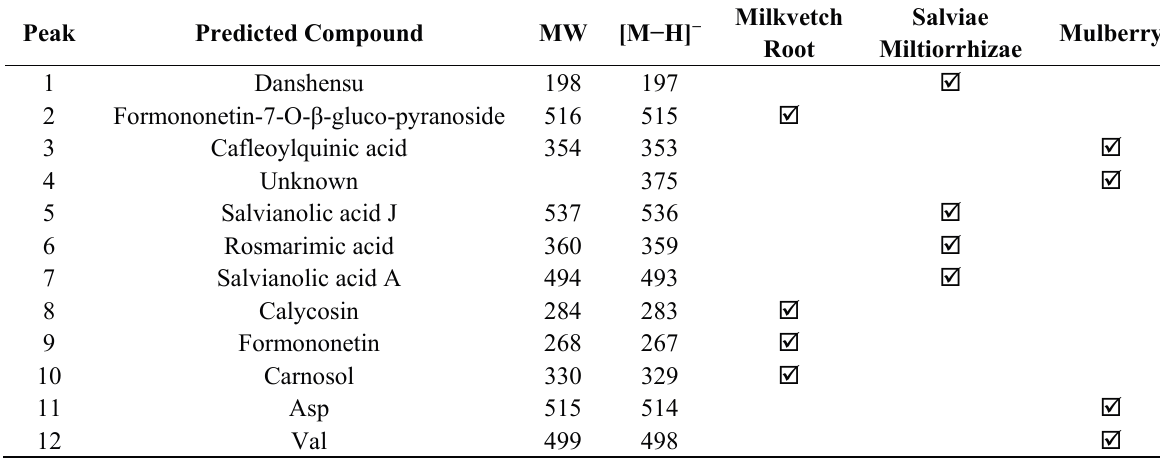
Table 3. HPLC-MS preliminary analysis of